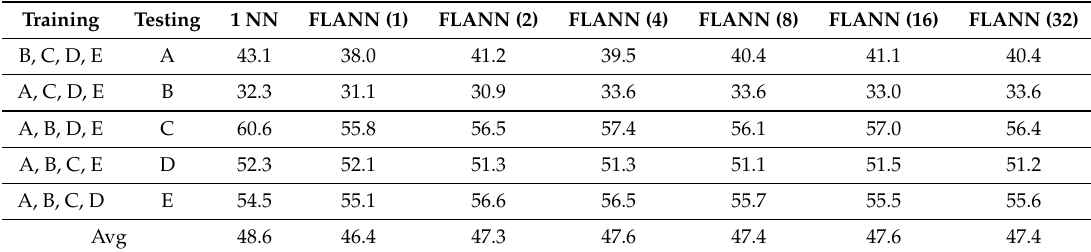
Table 11. 1 NN vs. FLANN with a different number of trees (given in